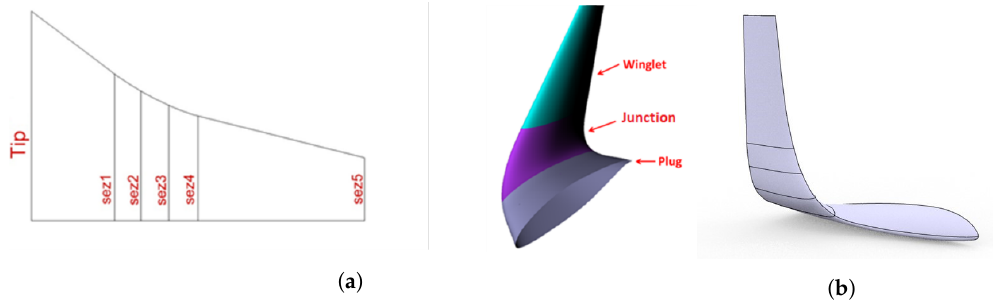
Figure 25. Tip winglet: ( a ) Design sections; ( b ) design three-dimensional overview.